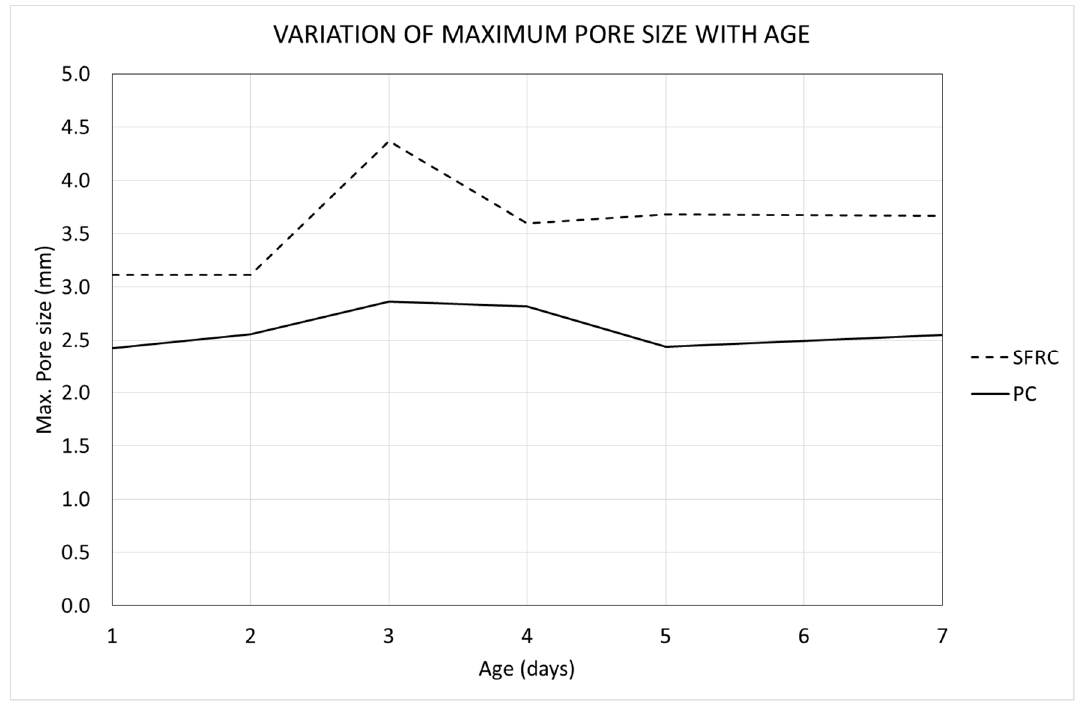
Figure 17. Variation of the nominal maximum pore size (NMPS) with the age.